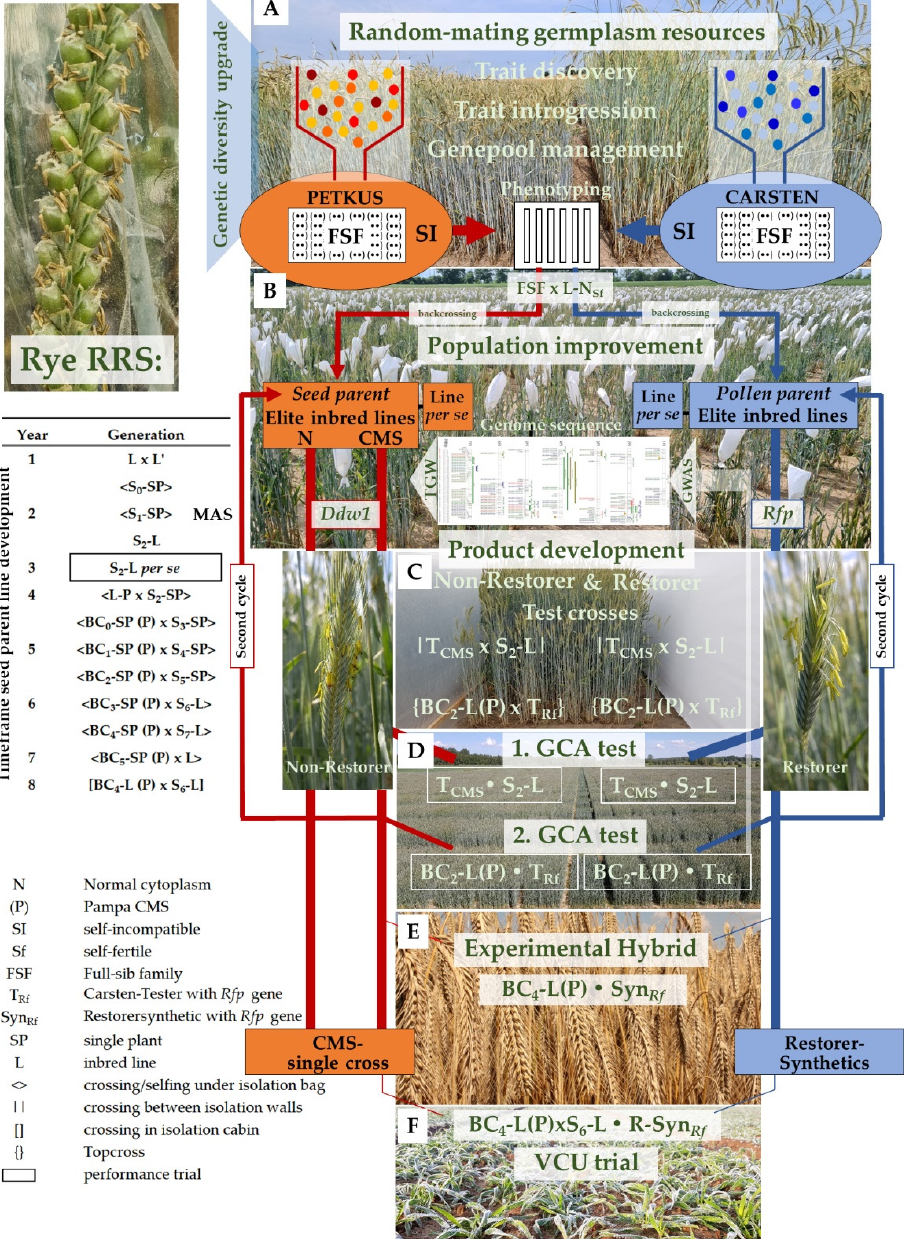
Figure 8. Flow chart illustrating a reciprocal recurrent selection (RRS) scheme in rye. ( A ) Random mating germplasm resources serve as an upgrade in genetic diversity. The coloured circles represent different alleles that are systematically captured and introgressed in both heterotic gene pools. ( B ) Improvement of the breeding population is based on self-fertile rye inbred lines as highly versatile tools for testing the effect of genes and gene combinations on plant phenotypes. Knowledge how the genome builds, maintains, and operates rye gained for example by Genome-wide Association Studies (GWAS) allows to increase selection efficiency for traits such as thousand-grain weight (TGW) by marker-assisted selection (MAS), as already realized for Dominant dwarf 1 ( Ddw1 ) and Restorer-of-fertility genes for Pampa CMS ( Rfp ). ( C ) Hybrid breeding enables to select crossing part- ners on a rational basis. Testcrosses are established between isolation walls or as topcrosses using cytoplasmic male sterility as a condition for large scale seed production, as CMS tester (T CMS ) geno- types of rye are unable to produce functional pollen. ( D ) The general combining ability (GCA) of parental genotypes is estimated based on testcross performance in four (1. GCA test) to ten (2. GCA test) target environments of rye cultivation. ( E ) The generation and evaluation of restorer synthetics